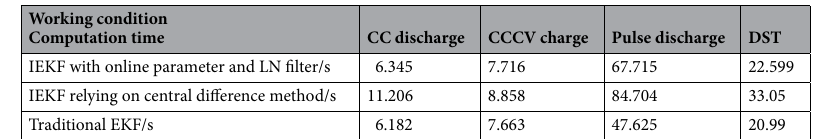
Table 11. Comparation of calculation